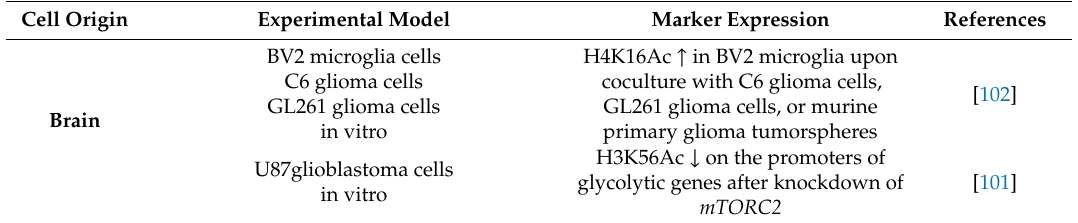
Table 1. Expression of histone acetylation and methylation markers in cancer cell